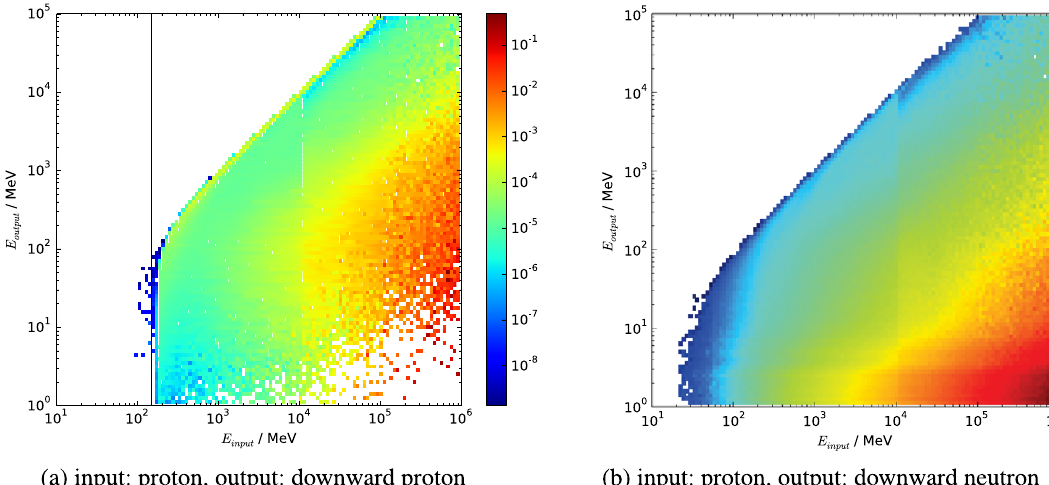
Fig. 1. 2-d histogram of (a) proton-downward proton matrix and (b) proton-downward neutron matrix under a vertical column depth of 20 g/cm 2 . X -axis and Y -axis stand for the input and output energies [MeV] respectively. The vertical line in (a) marks the 150 MeV input proton energy. The probabilities of a proton with certain primary energy producing secondaries with different energies are represented by colors using a logarithmic color distribution. Each column in this plot is equivalent to a normalized output spectrum obtained by PLANETOCOSMICS using protons of the corresponding input